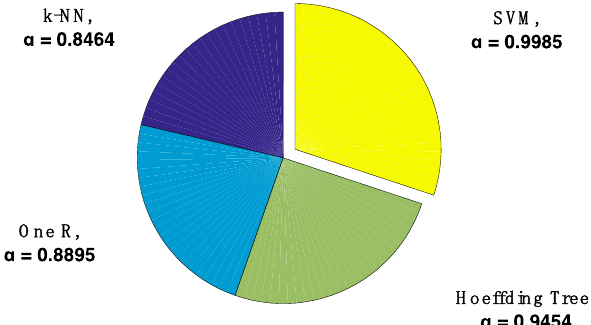
Figure 8. Classifiers prediction accuracy.